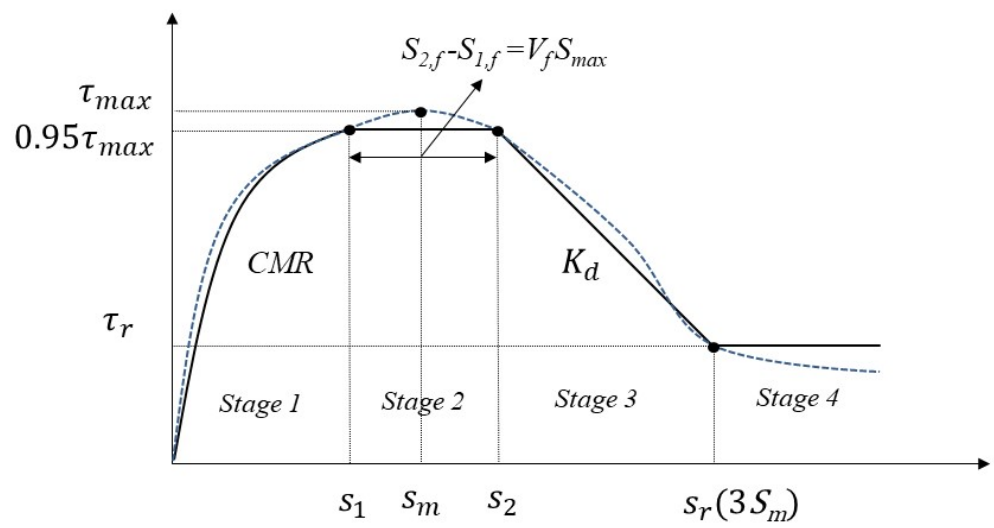
Figure 15. Proposed model for UHPC-coated steel rebar.